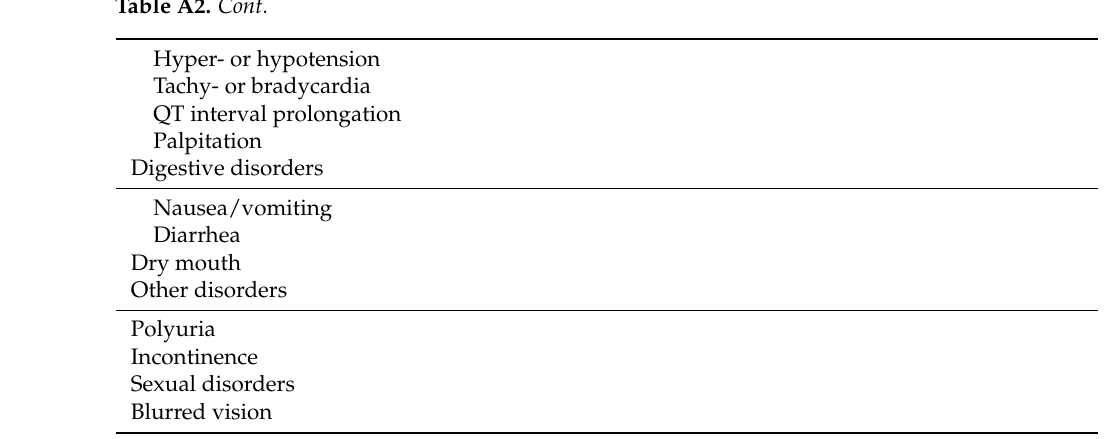
Table A3. Key pharmacokinetic parameters of cocktail drugs and their CYP-mediated metabolites.